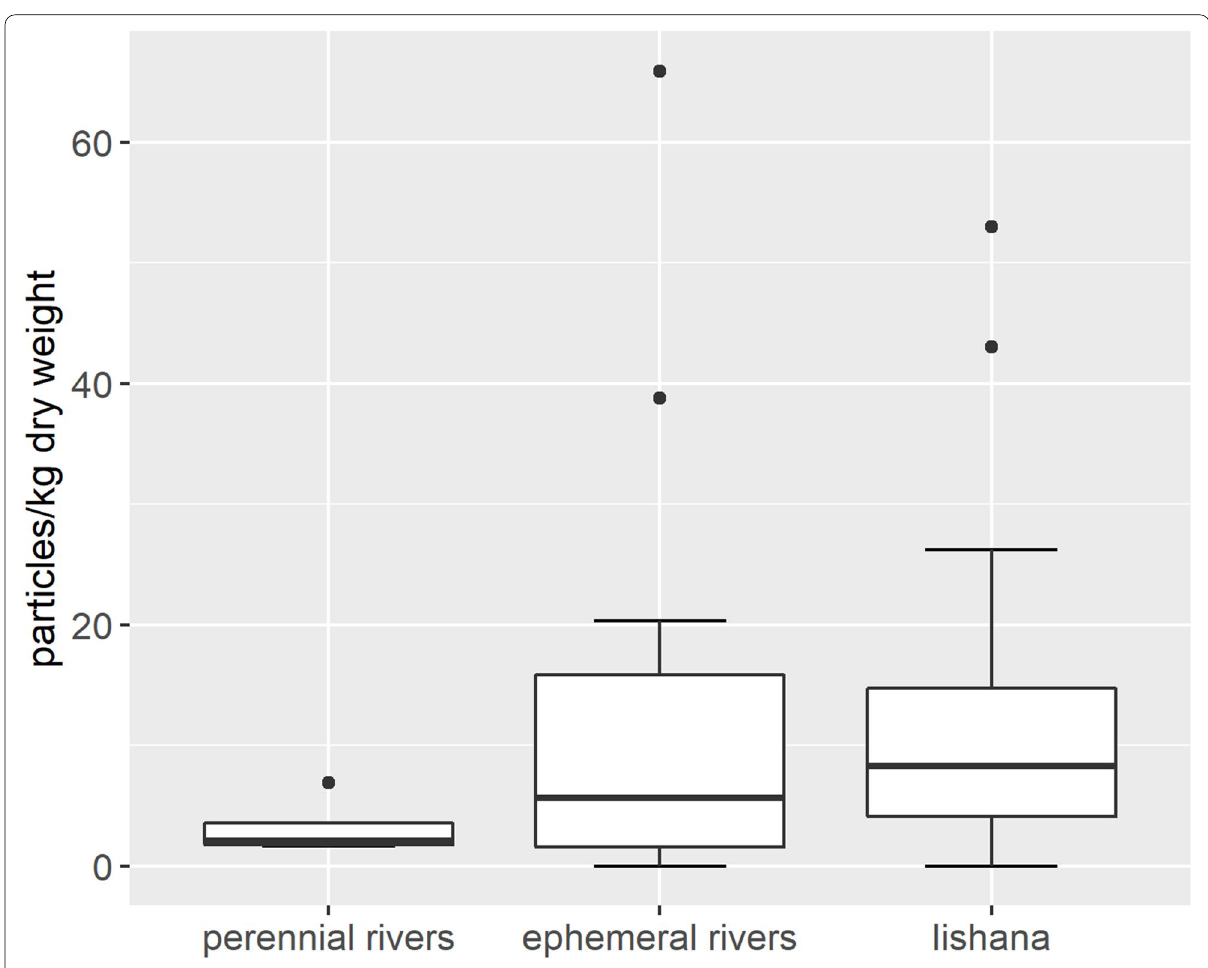
Fig. 8 Comparison of the amount of microplastics at the three river systems (perennial rivers, ephemeral rivers and the Iishana system)